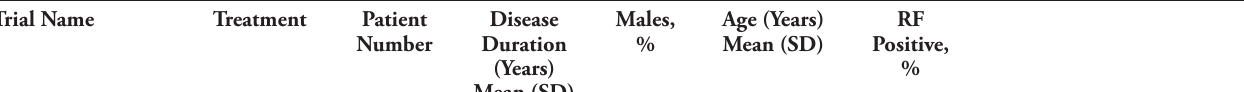
Table 1. Population characteristics: MTX-IR,